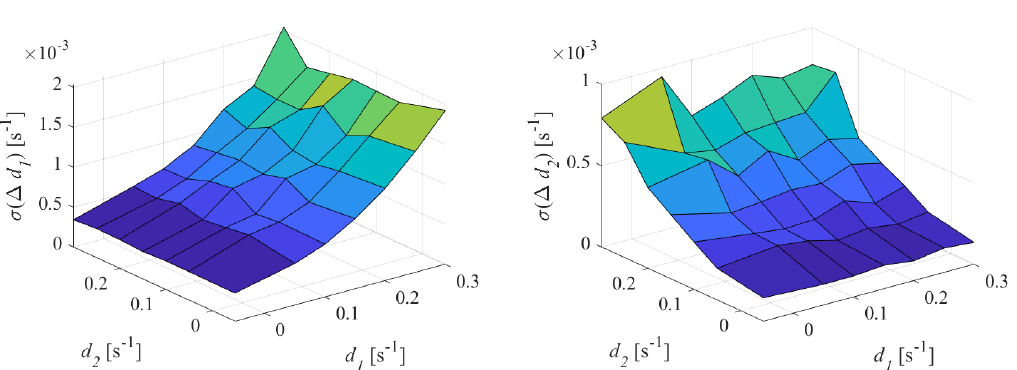
Figure 14. Standard deviation of ∆ d versus damping coefficients obtained in experimental tests with digitized signals; results for frequency f 1 ( on the left ) and f 2 ( on the right